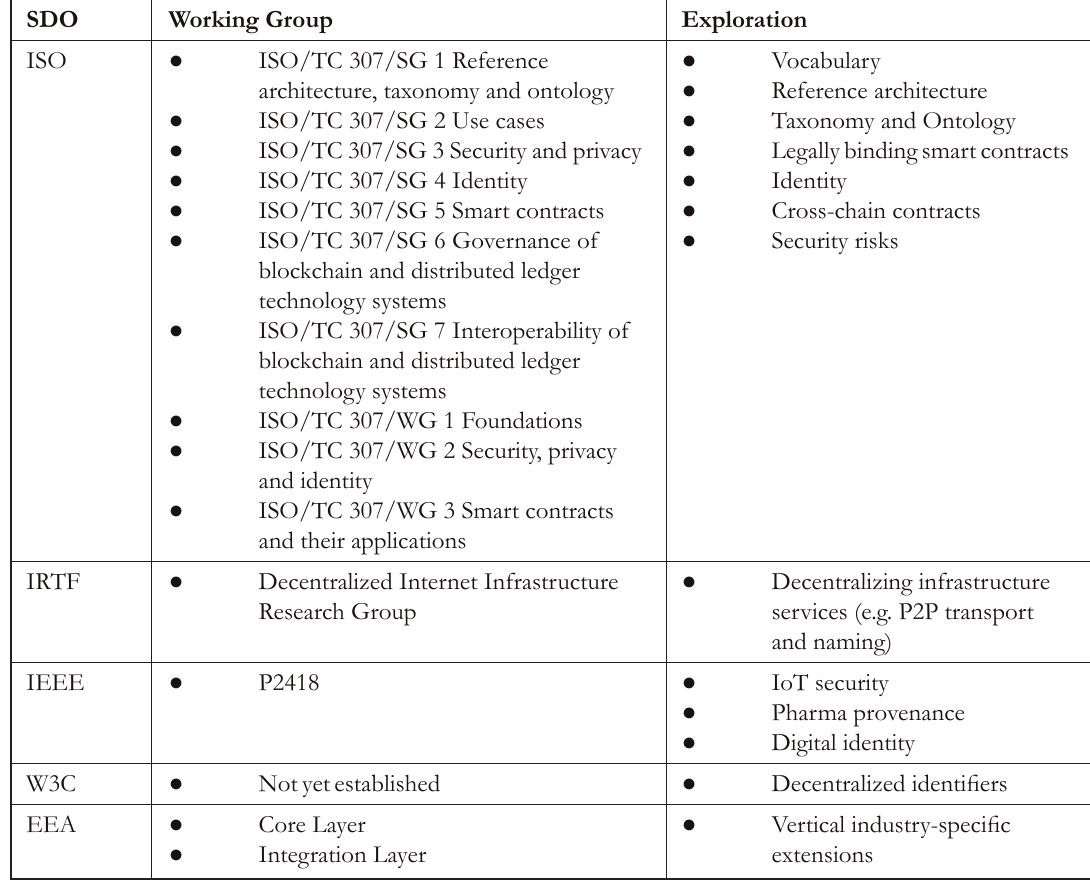
Table 4. Current Explorations by Standards Development